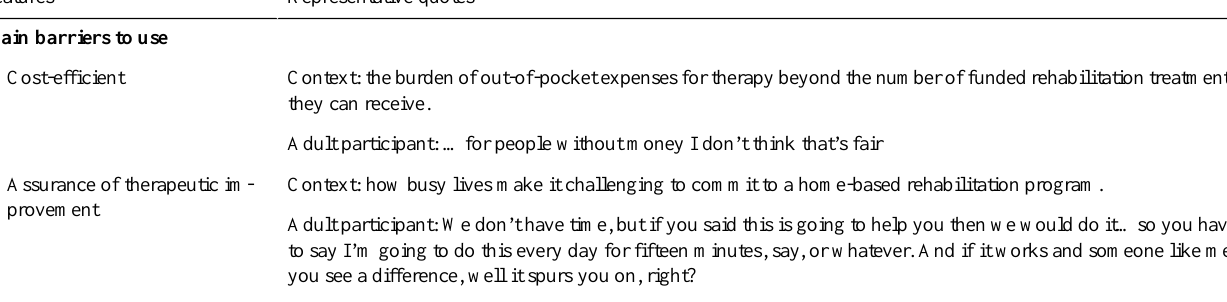
Table 2. Summary of main barriers to use and main enablers to therapy for adult focus group. Representative